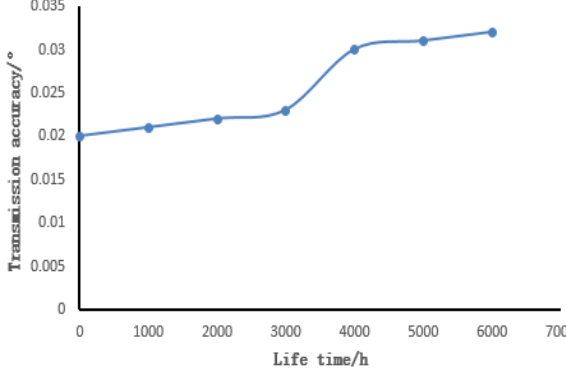
Figure 8. Transmission accuracy curve at torque 5 N.m.